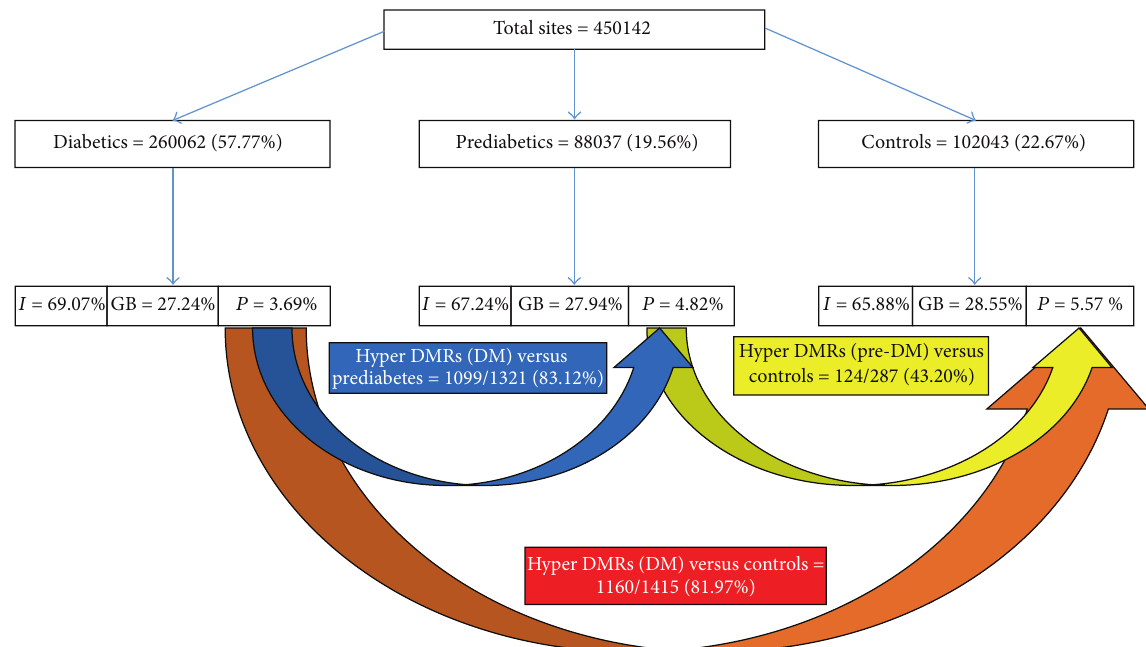
Figure 1: MeDIP-enriched regions (peaks) identified in all the samples. Total sites are the sum of the peak numbers for subjects with diabetes, subjects with prediabetes, and controls and include all the peaks that may be common/redundant across the conditions, as well as the peaks unique to each condition. Distributions of peaks in intergenic (I), gene body (GB), and promoter (P) regions are shown. Statistically significant MeDIP-enriched regions (peaks) were detected by MACS2 and identified by comparison to a Poisson background model, using a q -value threshold of 10 −2 . MAnorm was used to calculate differentially methylated regions with statistical significance. The differentially methylated regions located within gene promoters [TSS − 2000 bp; TSS + 2000 bp] are selected and provided. By peak number, there are more hypermethylated peaks in individuals with diabetes (82%) than in the control